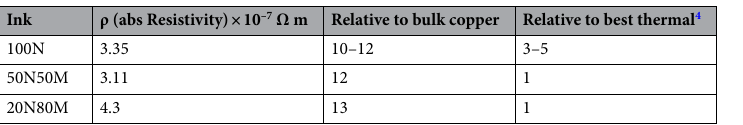
Table 2. Absolute resistivity relationship for each material for the 600 µm